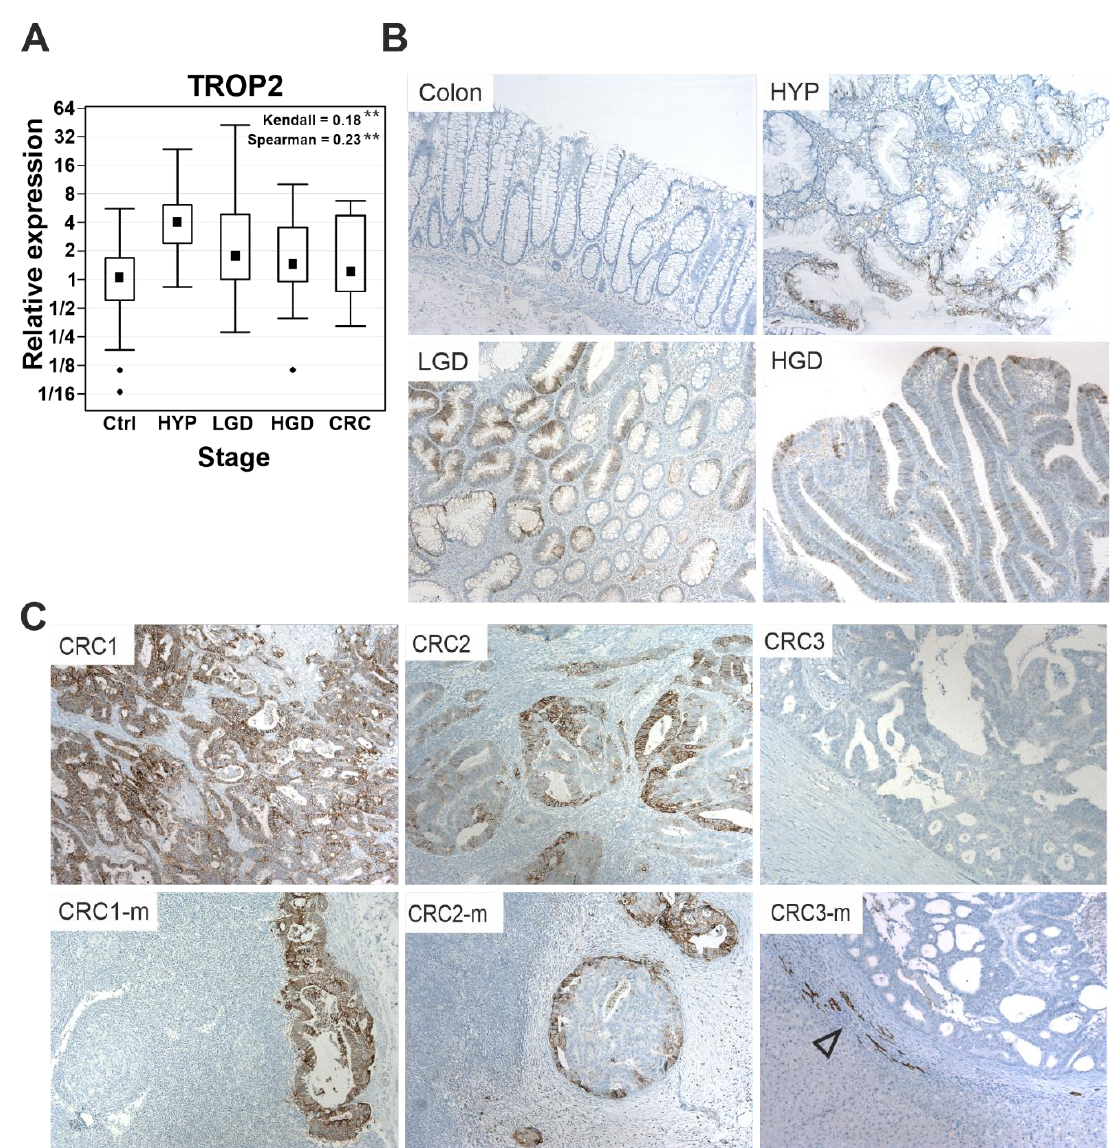
Figure 1. TROP2 gene expression and protein localization in human adenoma and adenocarcinoma samples. ( A ) Upregulated TROP2 gene expression at different stages of the neoplastic transformation sequence; TROP2 expression levels at the indicated tumor stage were compared with healthy colon biopsy samples. Data are presented as medians (black squares), 25th and 75th percentiles (boxed areas), and minimum and maximum values (“whiskers”); outlier values are also indicated (small rotated black squares). The association between the TROP2 expression profile and the histology grade of the neoplasia is significant, as shown by the Spearman and Kendall coefficient values. **, p < 0.01. ( B ) Representative microscopic images of immunohistochemical detection of TROP2 in normal colonic mucosa (colon) and in the indicated types of preneoplastic lesions. ( C ) Heterogeneous TROP2 expression in colorectal cancer; typical staining in adenocarcinomas with strong (CRC1), moderate (CRC2), and no TROP2 expression (CRC3) is shown. The corresponding lymphoid (CRC1-m and CRC2-m) or hepatic (CRC3-m) metastases have a TROP2 staining pattern similar to the primary tumor. Note the positive staining of intrahepatic cholangiocytes (empty arrowhead). All specimens were stained with substrate 3,3-diaminobenzidine (DAB; dark brown precipitate) and counterstained with hematoxylin (blue nuclear stain). Ctrl, healthy colon; HYP, hyperplastic polyps ( n = 9); LGD, adenomas with low-grade dysplasia ( n = 24); HGD, adenomas with high-grade dysplasia ( n = 25); CRC, invasive carcinoma ( n = 12); original magnification 100 ×